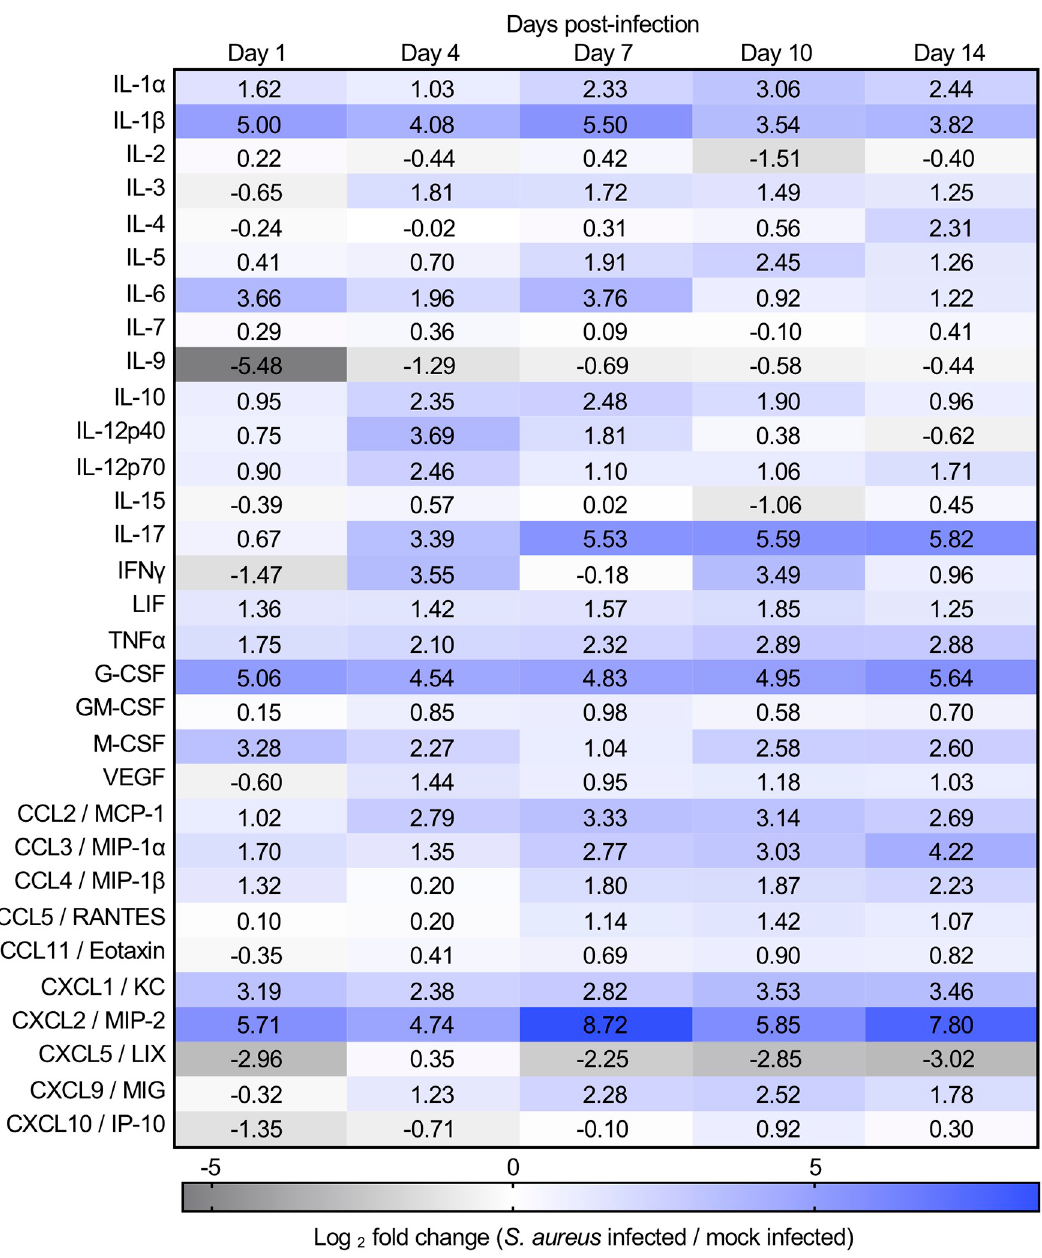
Fig 2. Longitudinal cytokine profiling defines the local inflammatory milieu during S. aureus osteomyelitis. Cytokine profiling was performed on homogenates from mock and S. aureus infected femurs from female WT mice. Groups of mock or S. aureus infected mice ( n = 3 per time point) were sacrificed on days 1, 4, 7, 10, and 14 post-infection. Relative cytokine levels are represented as Log 2 ( S. aureus infected/mock infected) to reflect changes in cytokine production between sterile and infected bones. Dark blue shading represents increasing cytokine fold-changes observed in S. aureus infected femurs compared to mock infected femurs. Dark grey shading represents a decreasing cytokine fold-changes in S. aureus infected femurs compared to mock infected femurs.